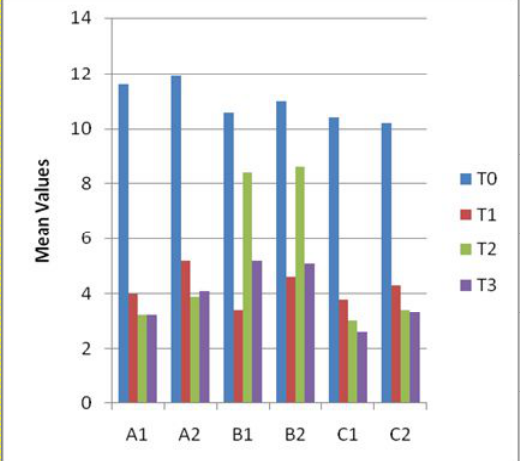
Figure 1: Mean values of Vita shade guide for all subgroups at baseline (T0), after bleaching (T1) after staining (T2) and after polishing